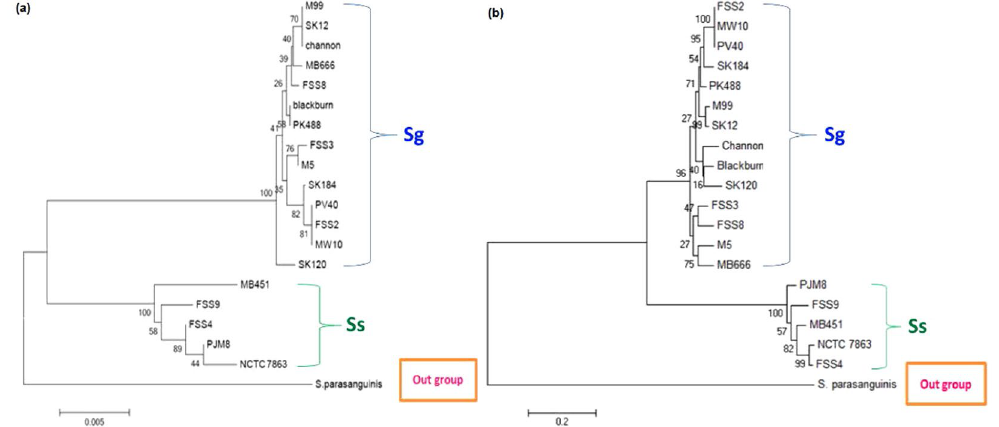
Figure 1. The single gene marker 16S rRNA phylogenetic tree ( a ) and core genome-SNP phylogenetic tree ( b ) classified 14 strains of Sg and 5 strains of Ss into different species clades using Streptococcus parasanguinis as the outgroup.